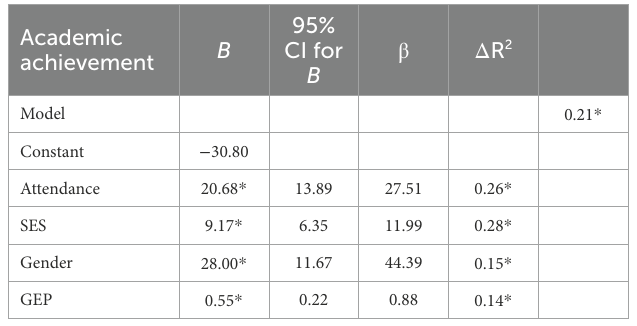
TABLE 3 Regression statistics for model with four predictor variables and academic achievement as outcome